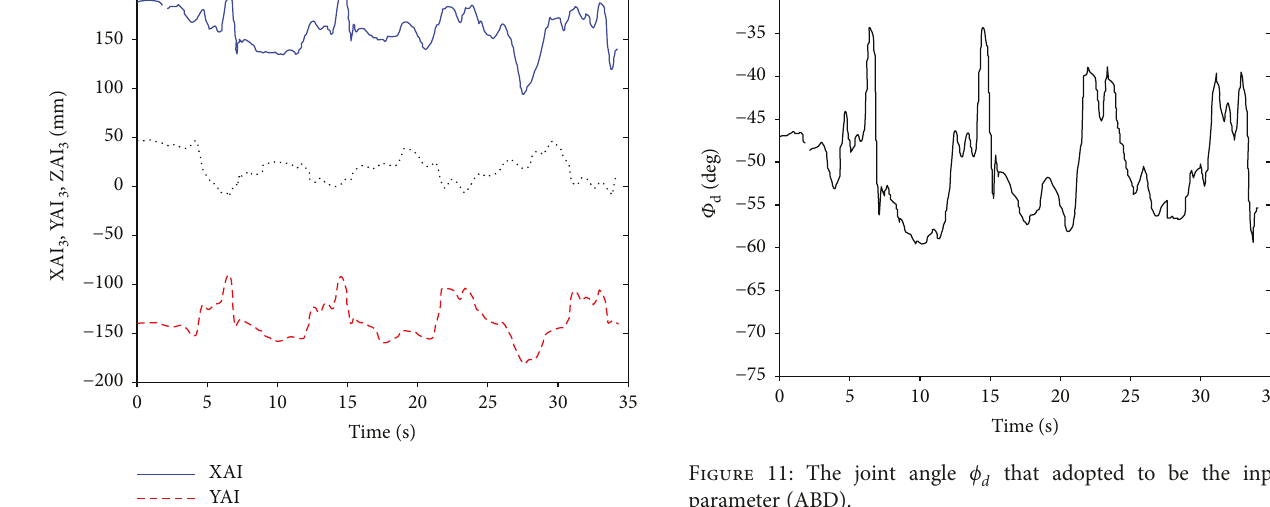
that adopted to be the input d